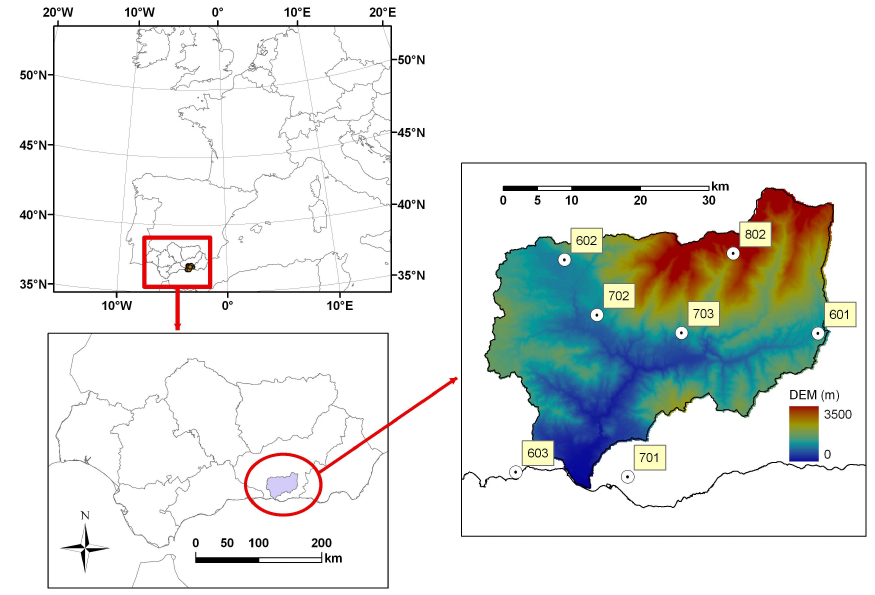
Fig. 1. Study site location, and weather stations 601, 602, 603, 701, 702, 703, 802 and DEM of the Guadalfeo river